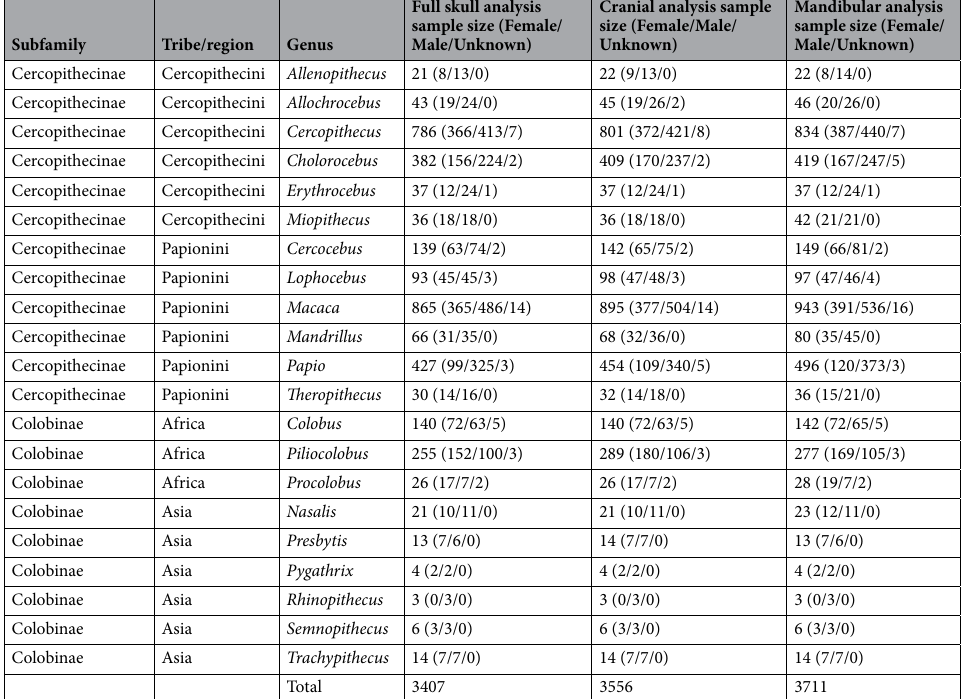
Table 2. Cercopithecidae sample sizes for each analysis in this